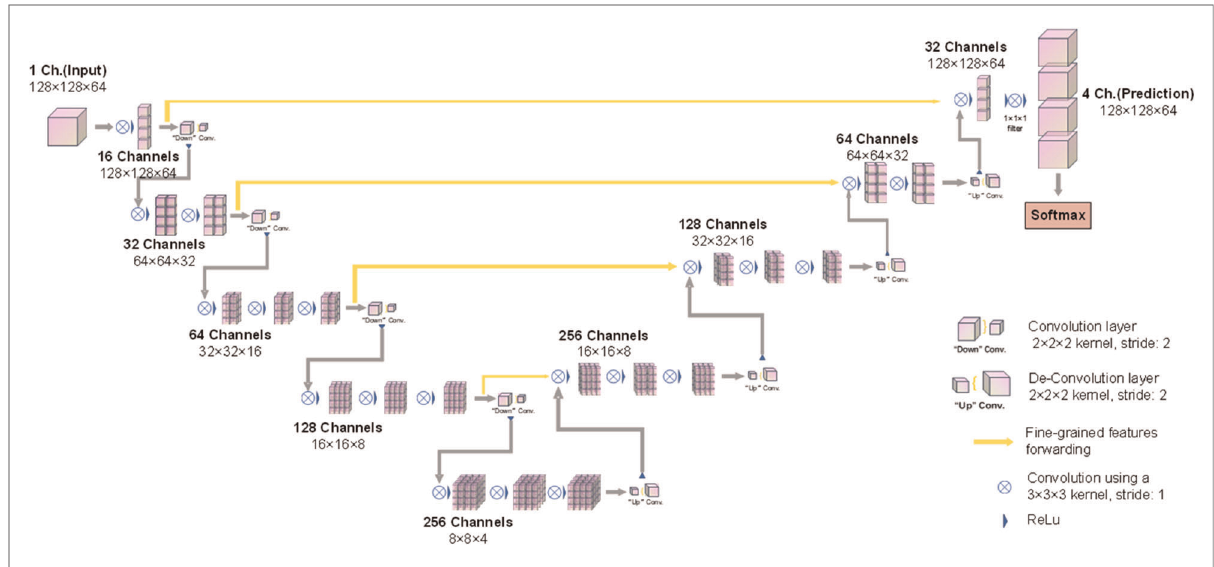
FIGURE 3 Schematic of the simpli fi ed V-Net network architecture (IFFCT).